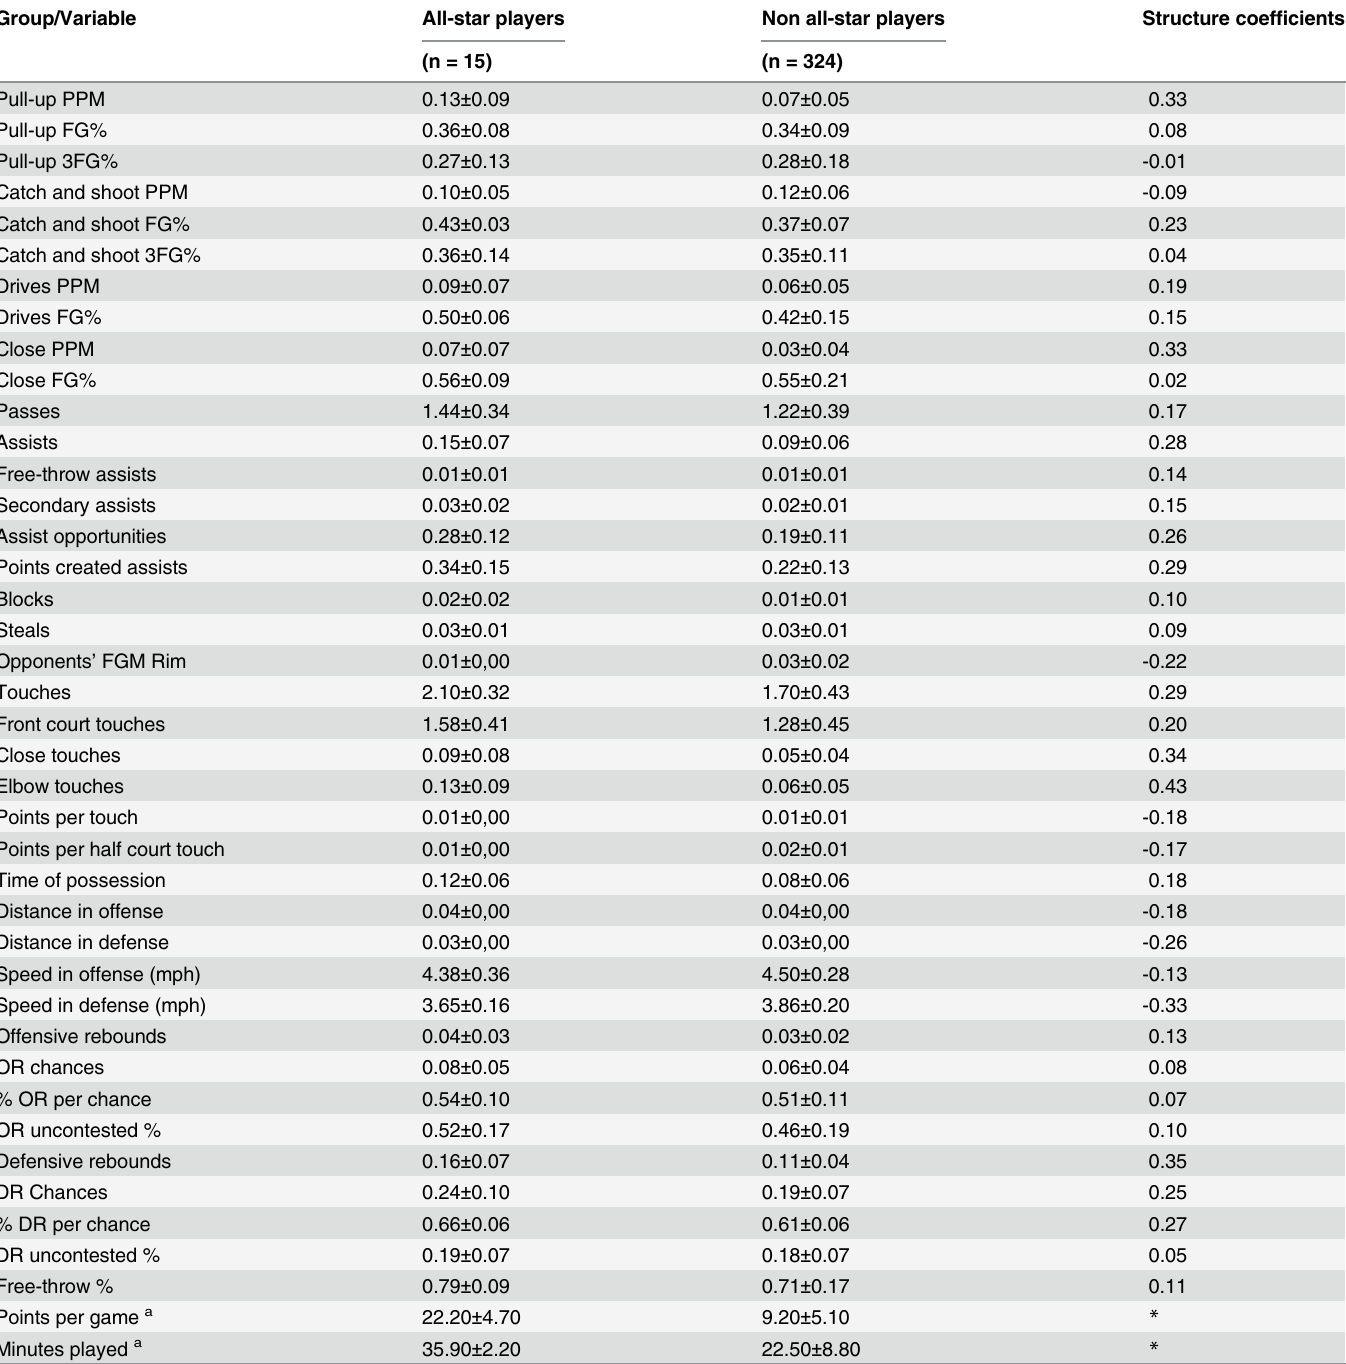
Table 1. Means, standard deviations and structure coefficients from all-star and non all-star categories. The variables expressed as counts were divided by minutes